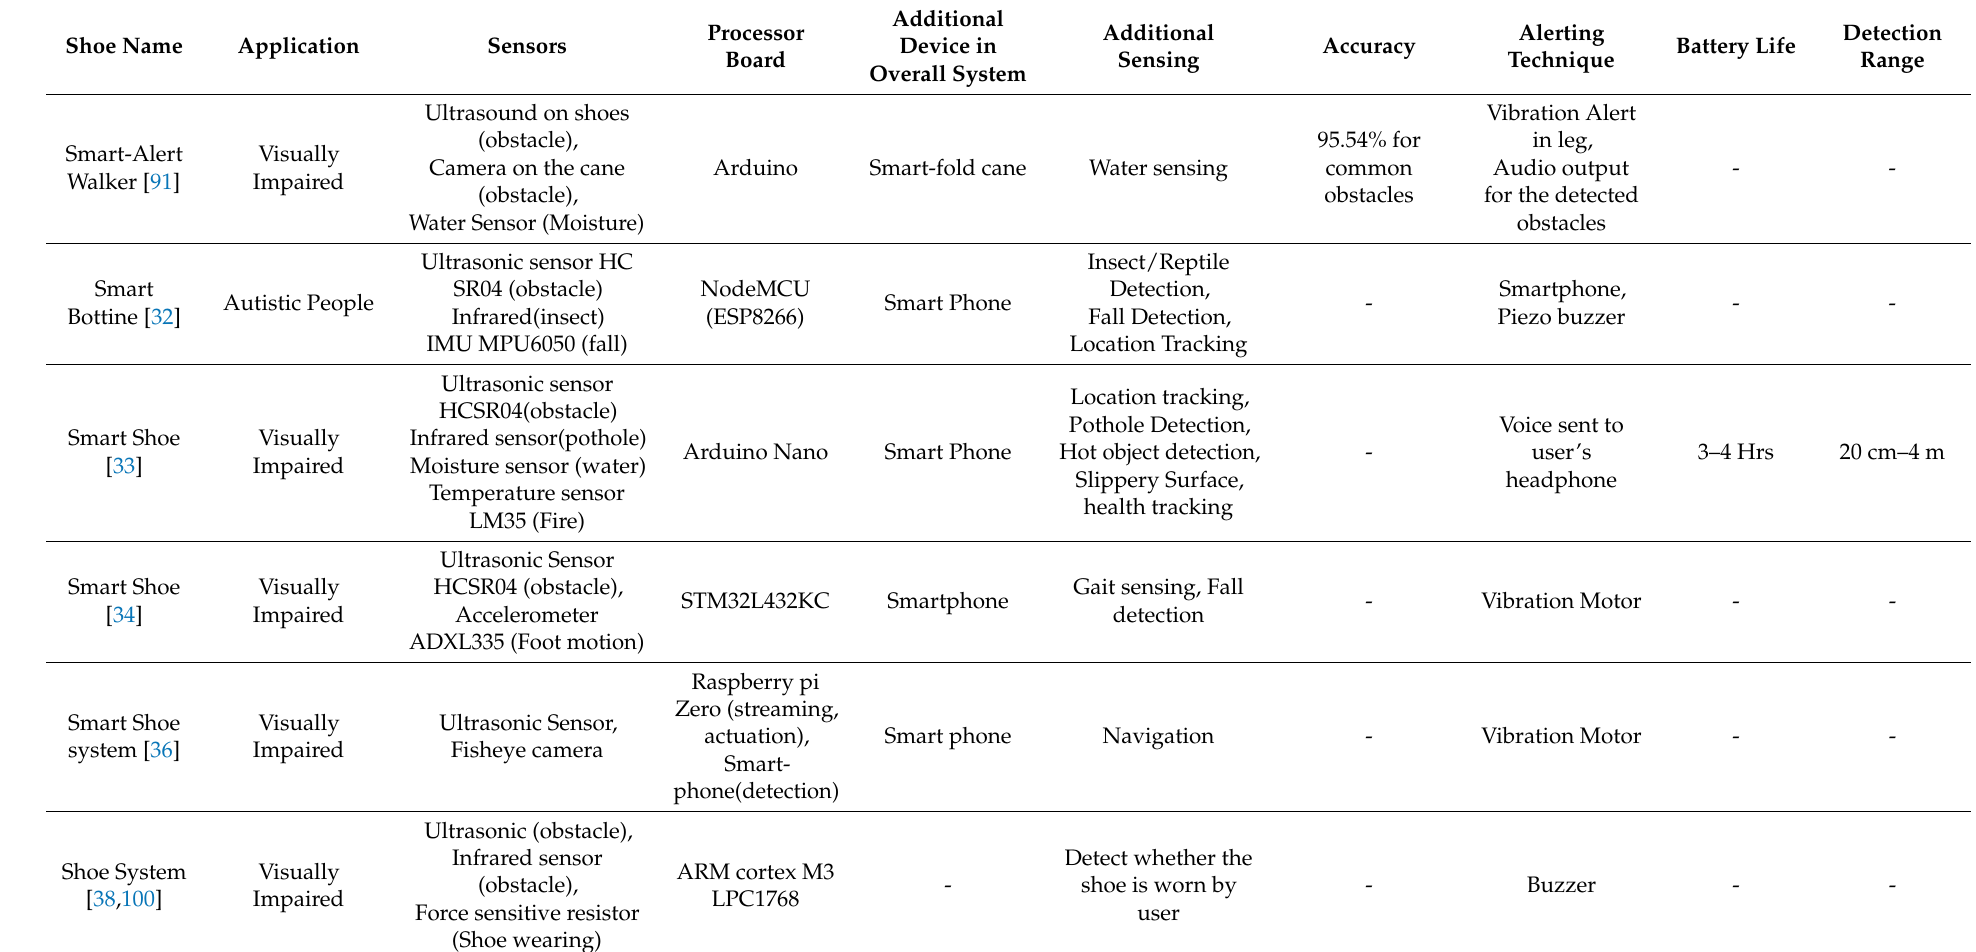
Table 5. Main features of the obstacle detection shoe systems taken from the reviewed